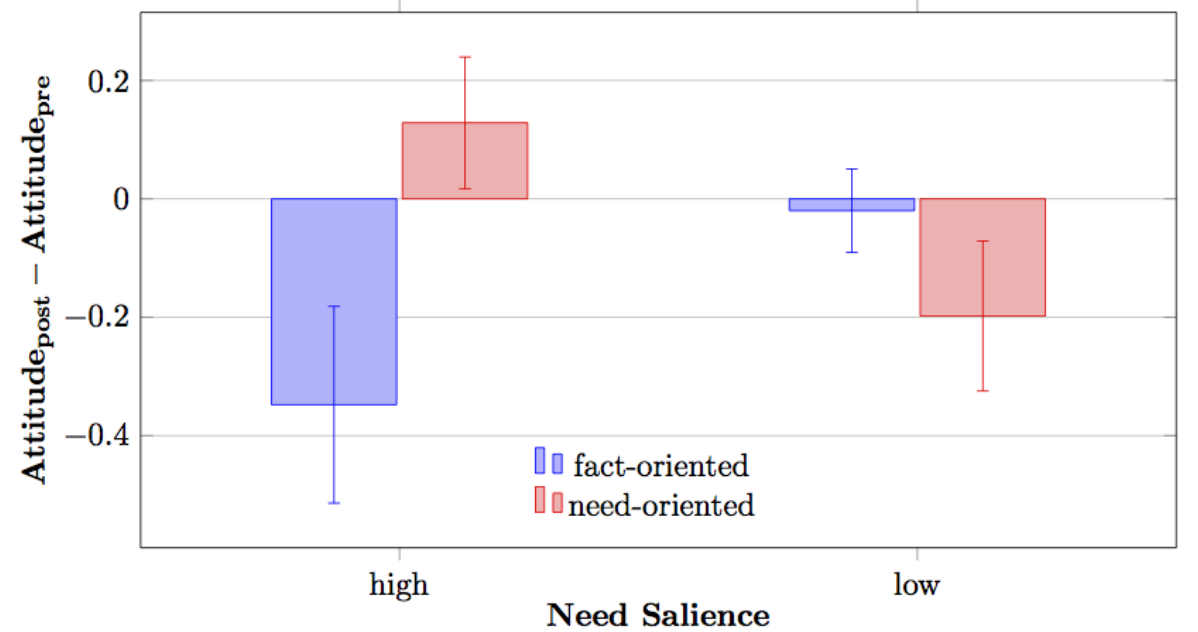
Figure 1. Interaction effect between communication style and need salience regarding attitude change. Standard errors are represented by error bars attached to each